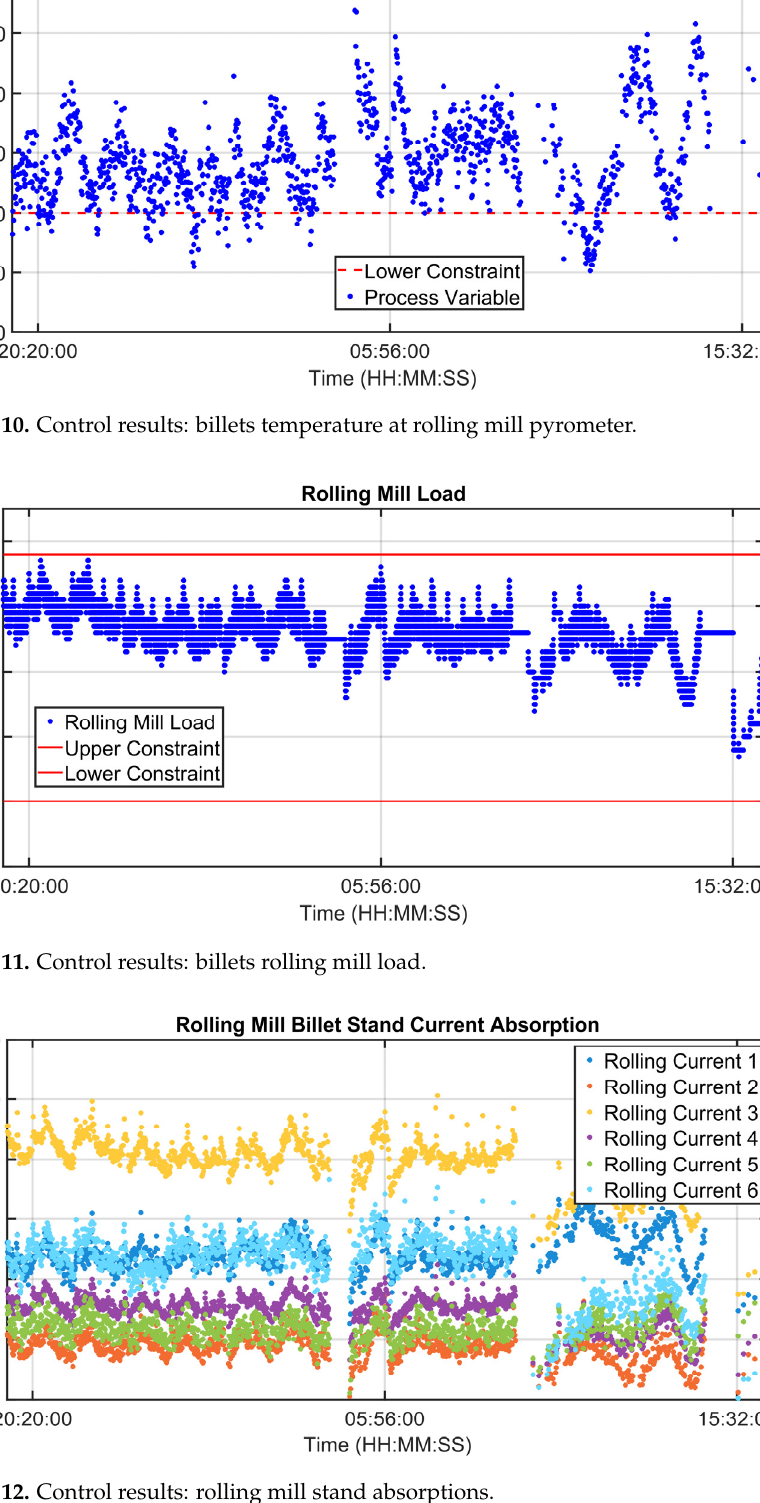
Figure 12. Control results: rolling mill stand absorptions.